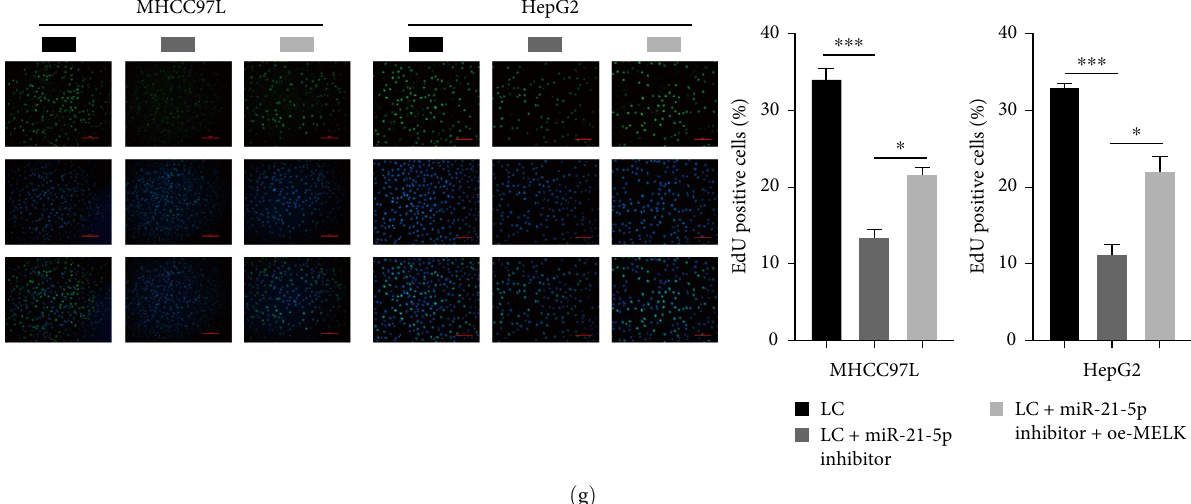
F IGURE 3: miR-21-5p targets MELK, and miR-21-5p can suppress the expression of MELK, thereby inhibiting tumor progression: (a) targeted binding sites of miR-21-5p and MELK predicted by starBase; (b) dual-luciferase reporter gene experiment verifying the targeted relationship between miR-21-5p and MELK; (c) Western blot for the level of MELK; (d) CCK8 for cell viability; (e) clonogenic assay for cell proliferation; (f) transwell assay for invasion and migration; (g) EdU staining for cell proliferation. ∗ P < 0 : 05, ∗∗ P < 0 : 01, ∗∗∗ P < 0 :